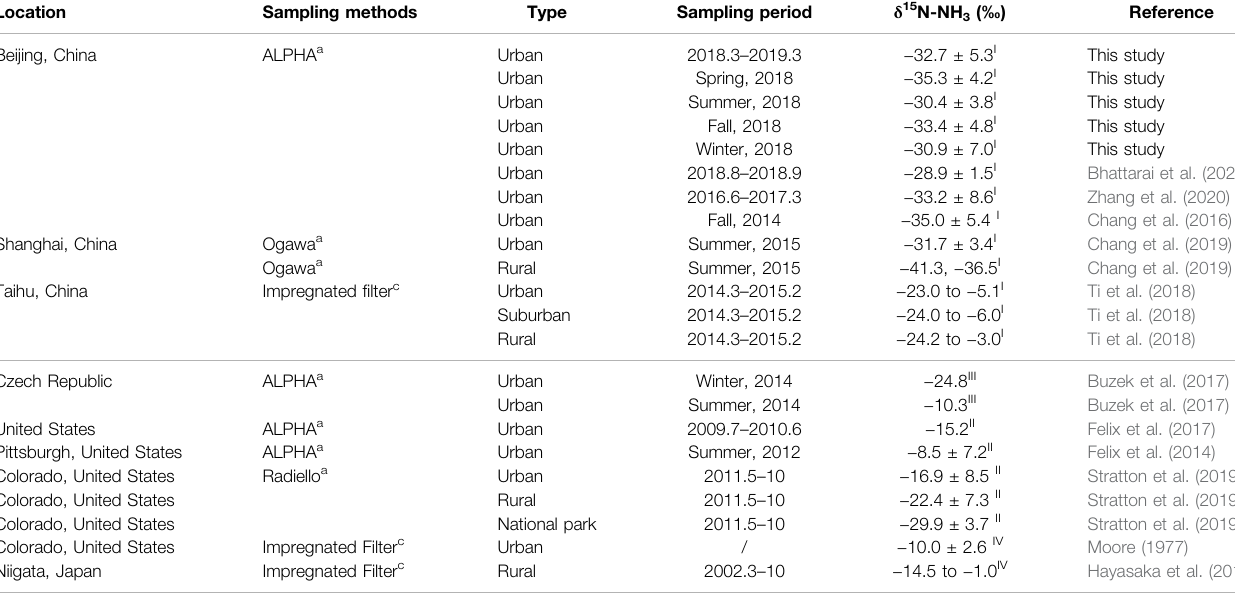
TABLE 3 | Comparison of concentration and δ 15 N values of ambient NH 3 concentration and δ 15 N-NH 3 values.